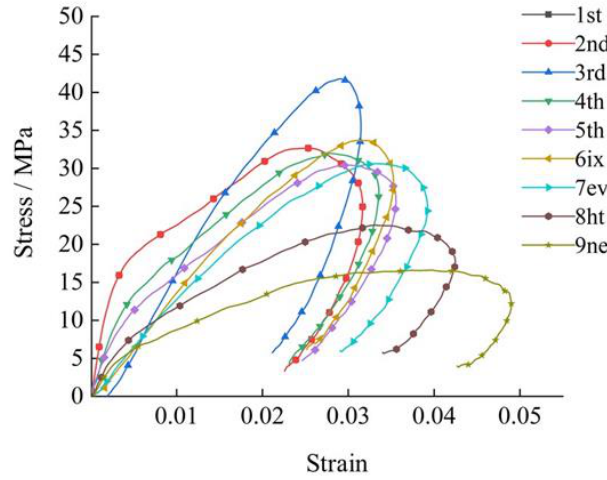
Figure 5. Typical stress–strain curve during cyclic impact.